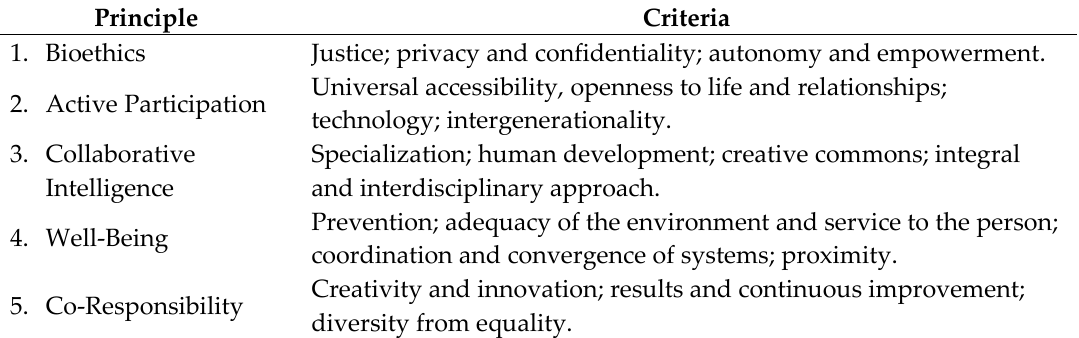
Table 1. Principles and criteria in the Dignified and Positive Ageing (DPA) model.